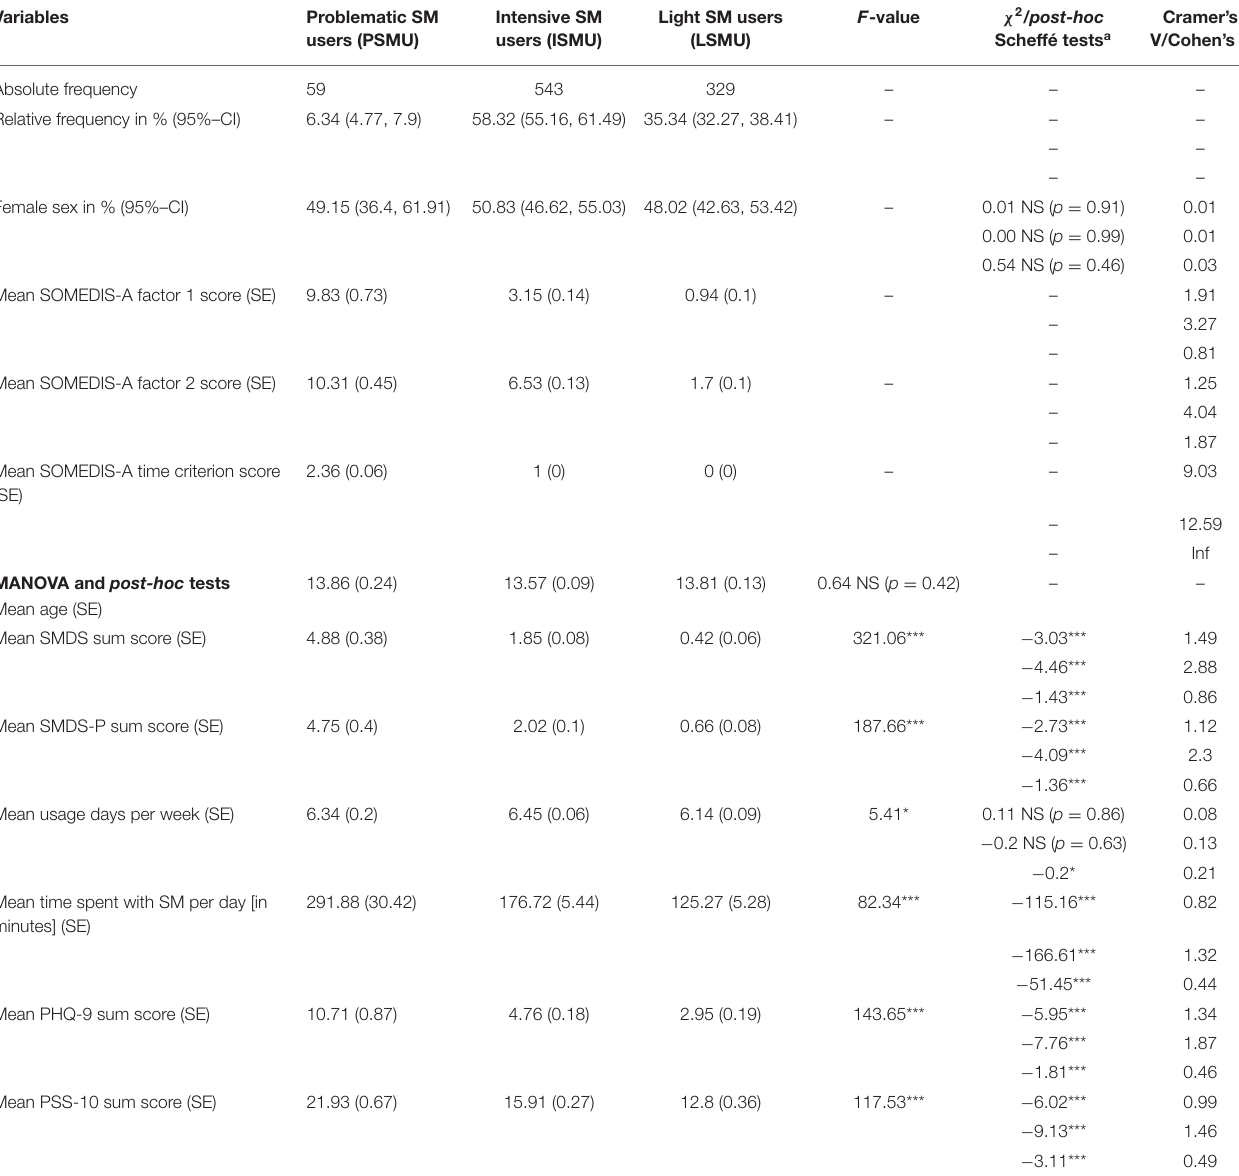
TABLE 8 | Comparison of the three SM user profiles based on LPA.